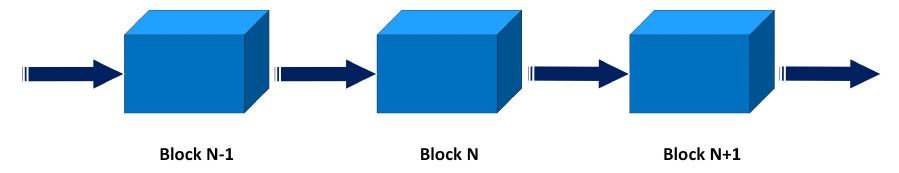
Figure 2. Blockchain